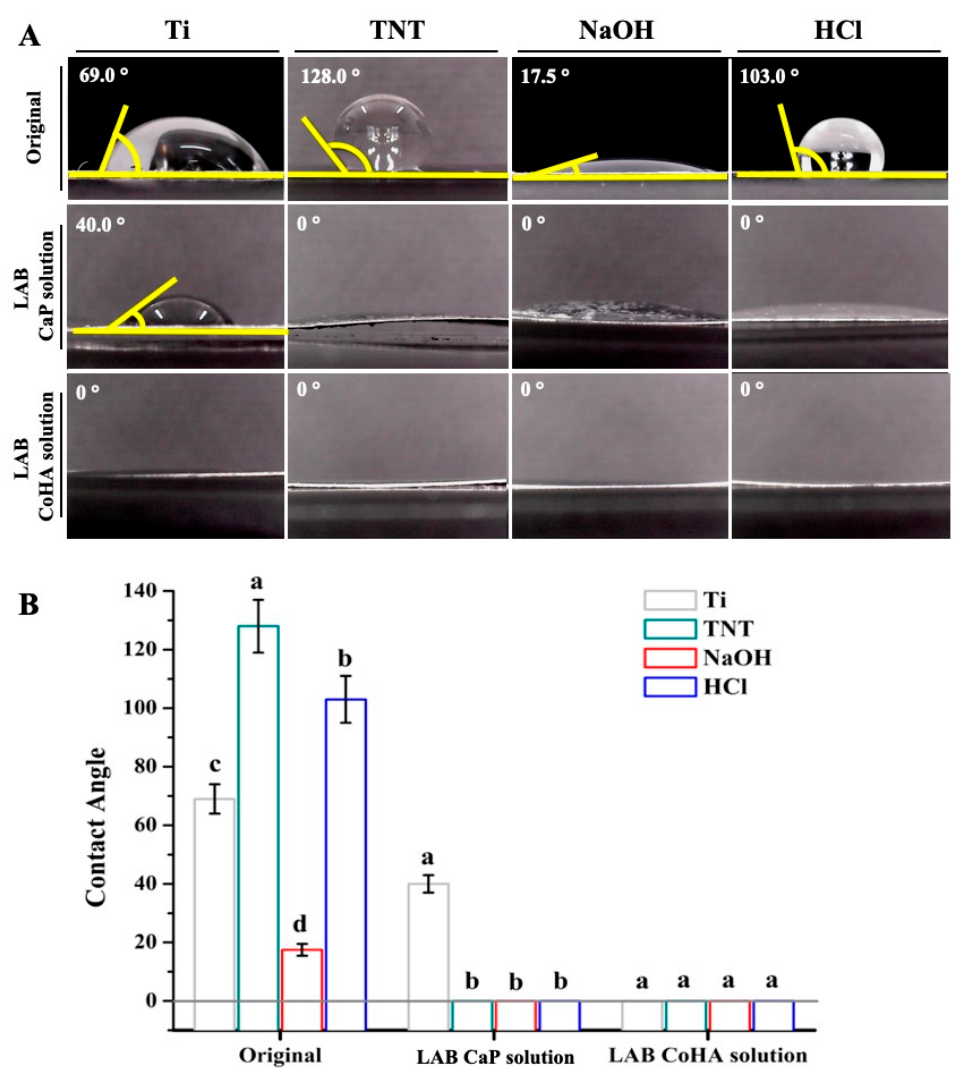
Figure 4. The surface wettability titanium sheet has different surface treatments. ( A ) Image of surface contact angle. ( B ) Quantitative analysis of the contact angle was performed. Means with different letters were significantly different ( p < 0.05, mean ± SD, n = 3).